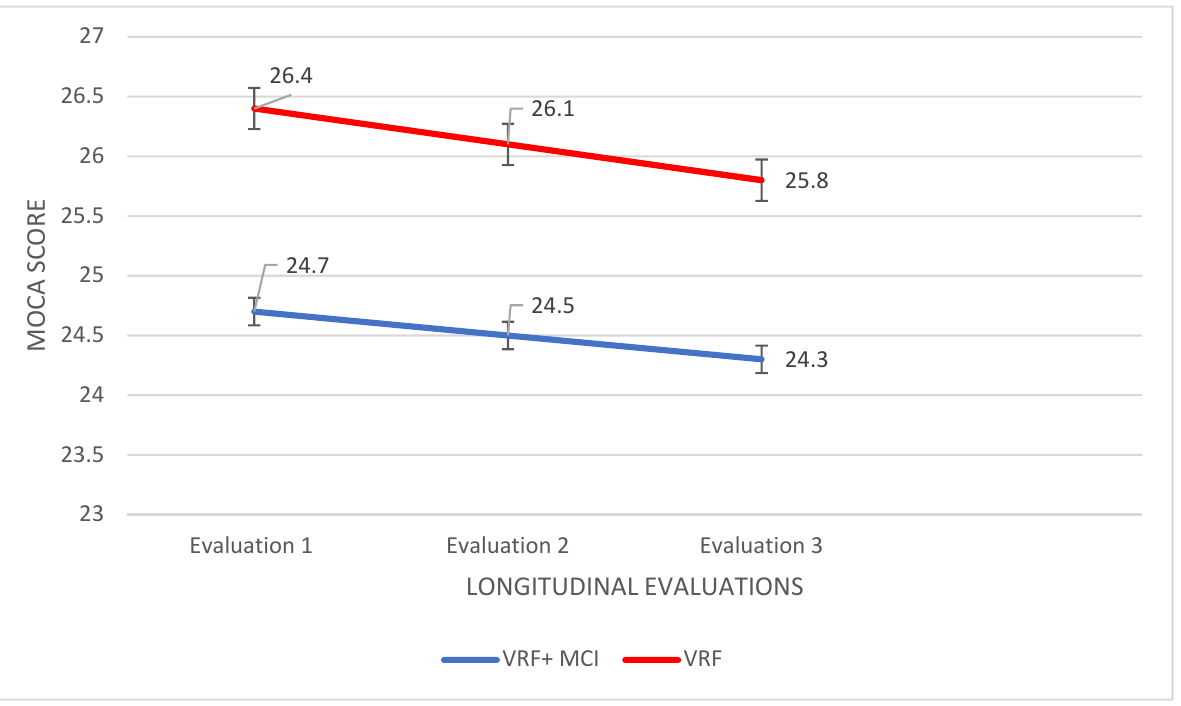
Figure 2. Performance of people with VRF and people with VRF + MCI in MoCA in the three times of assessment.